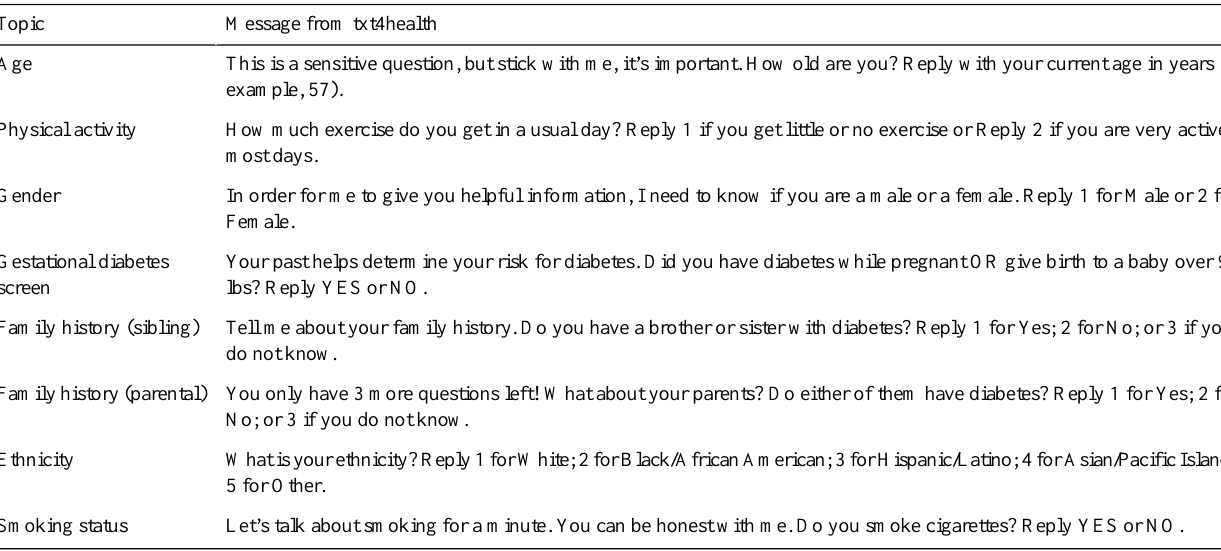
Table 1. Items from the txt4health diabetes risk assessment. Message from